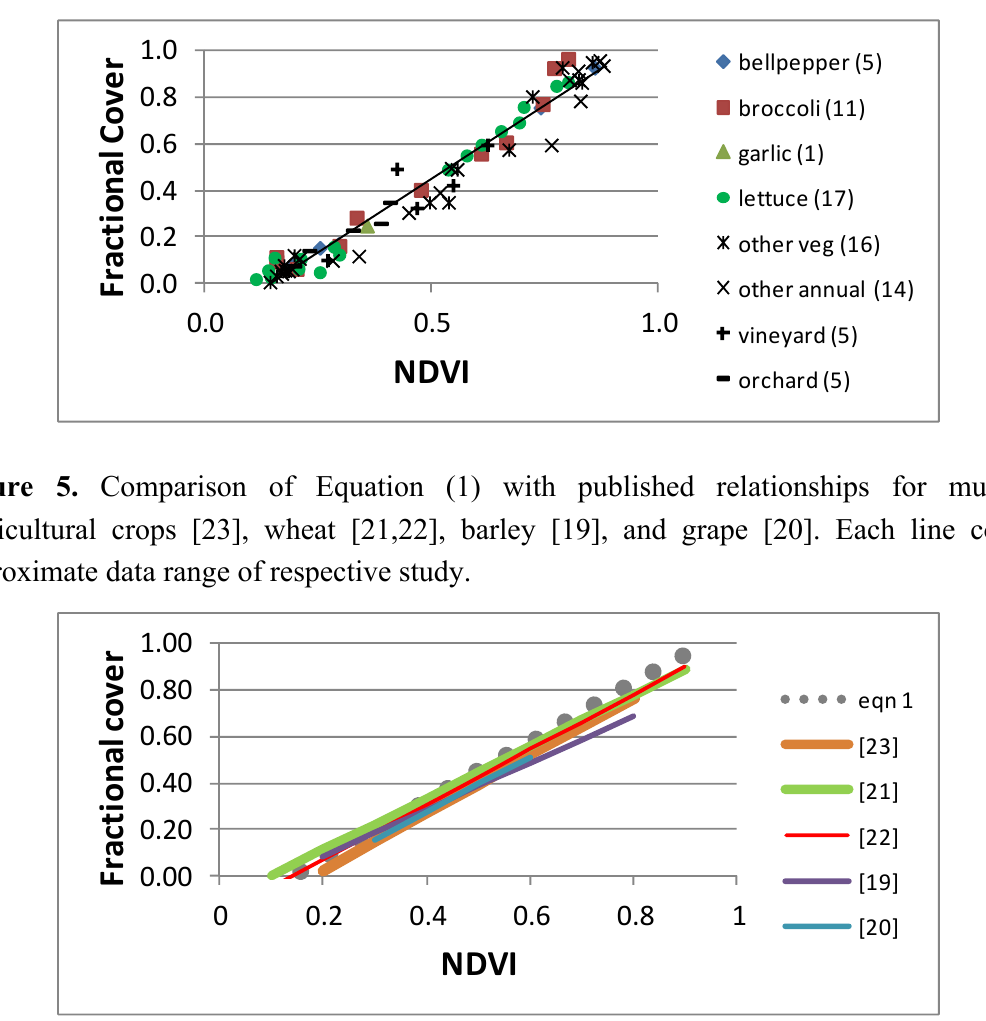
Figure 4. Relationship between Landsat NDVI and ground measurements of Fc. A total of 18 major SJV crop types and 11 satellite overpasses are represented. Number of observations of each crop type shown in parentheses.